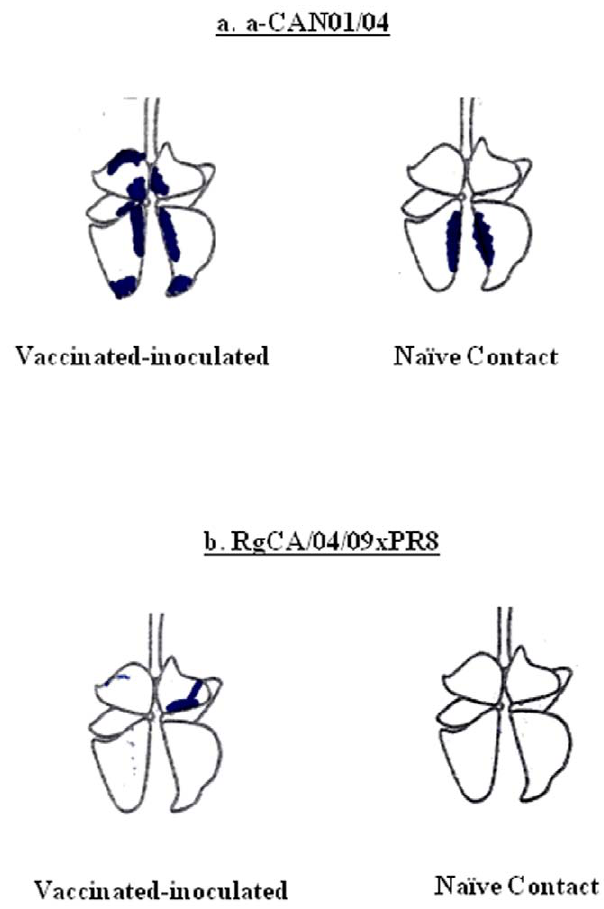
Figure 5. Gross pathological examination of lung tissue samples from infected and contact mini-pigs after challenge with the CA/04/09 virus. Lungs of 2-dose vaccinated [7.5 m g HA of either a-CAN01/04 (a) or RgCA/04/09xPR8 (b)] and subsequently challenged mini-pigs, including naı¨ve contact hosts, were harvested at 5 dpi to examine gross tissue morphological features after infection with the pandemic (H1N1) 2009 virus.